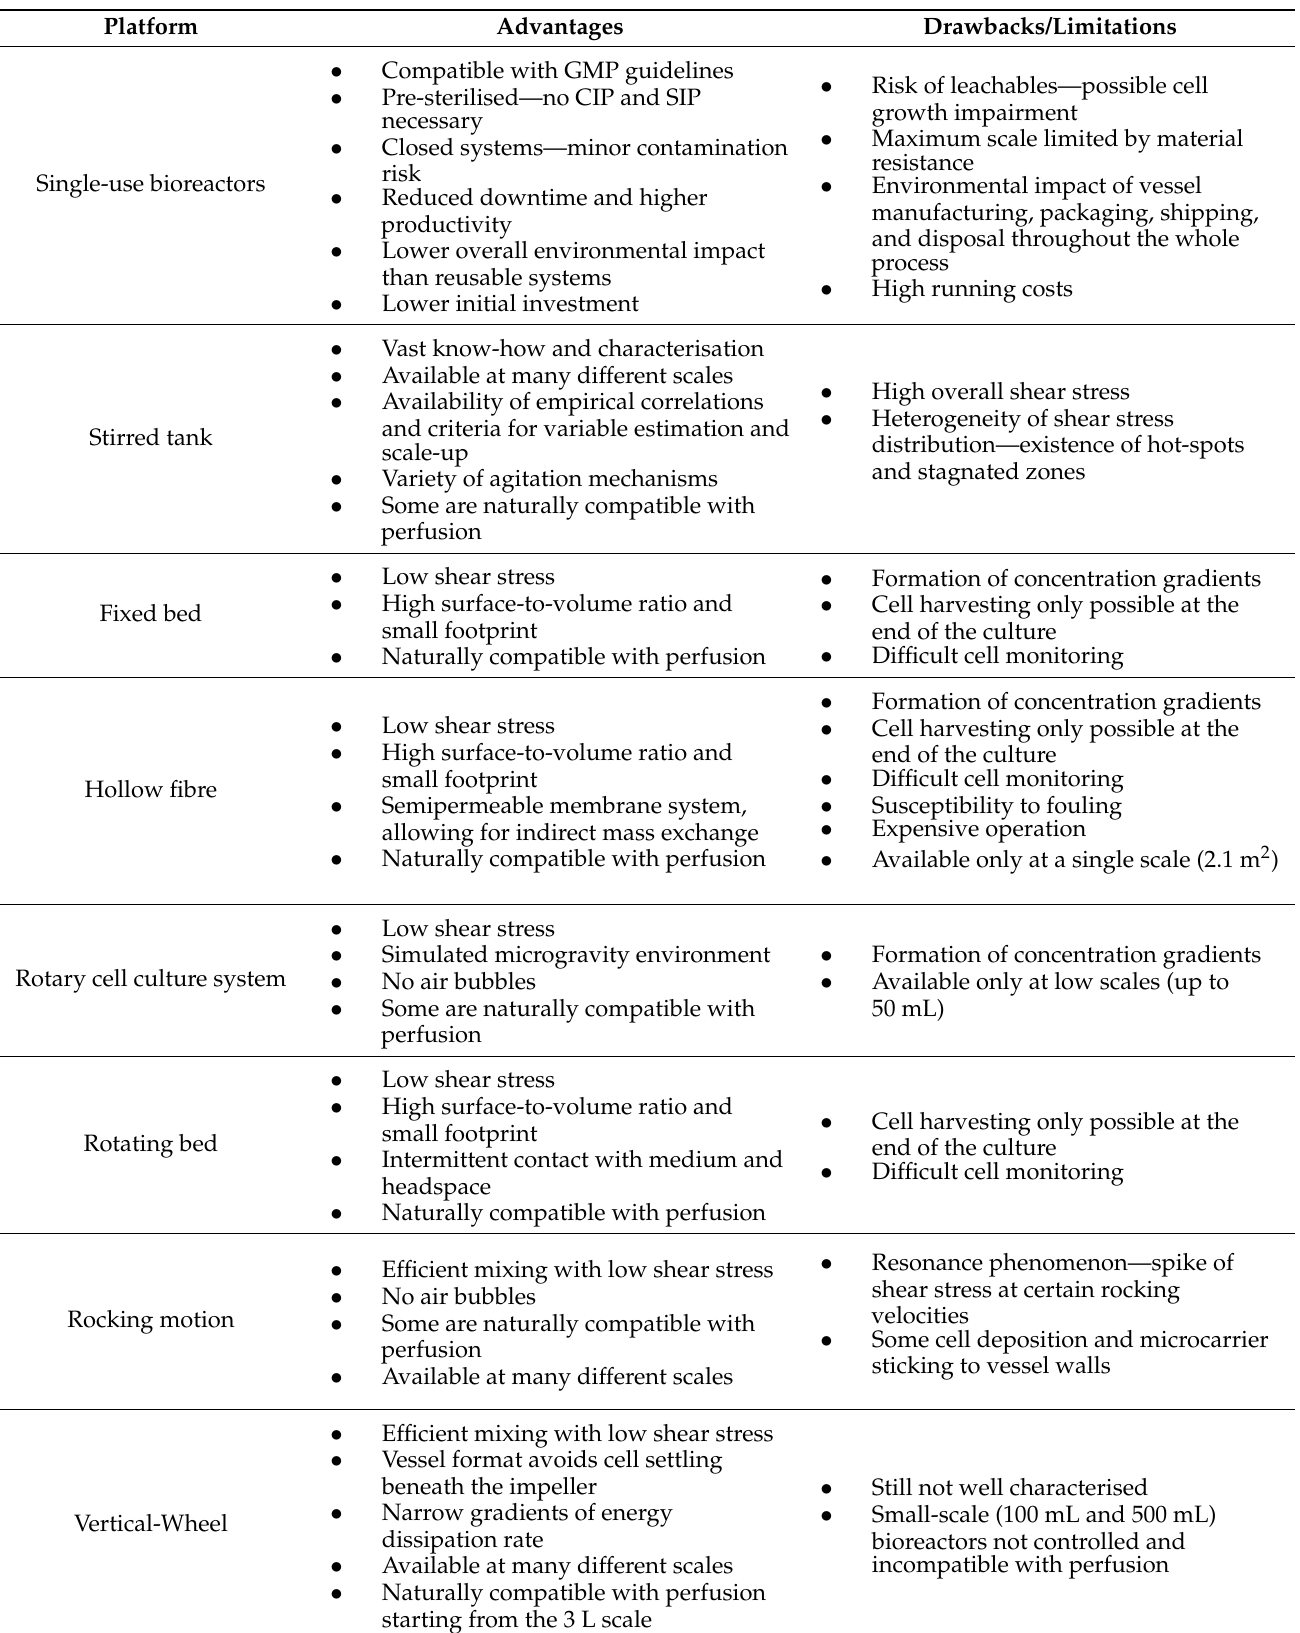
Table 3. Advantages and limitations of single-use bioreactors as whole and specific single-use